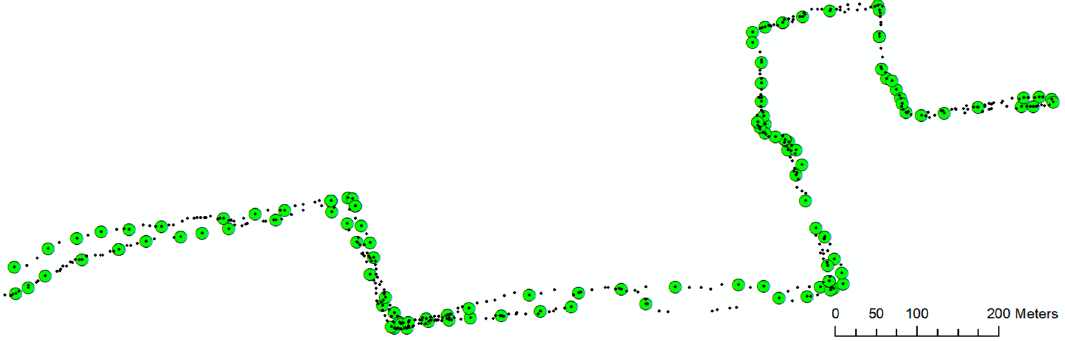
Figure 8. The final selected significant points (123 points).